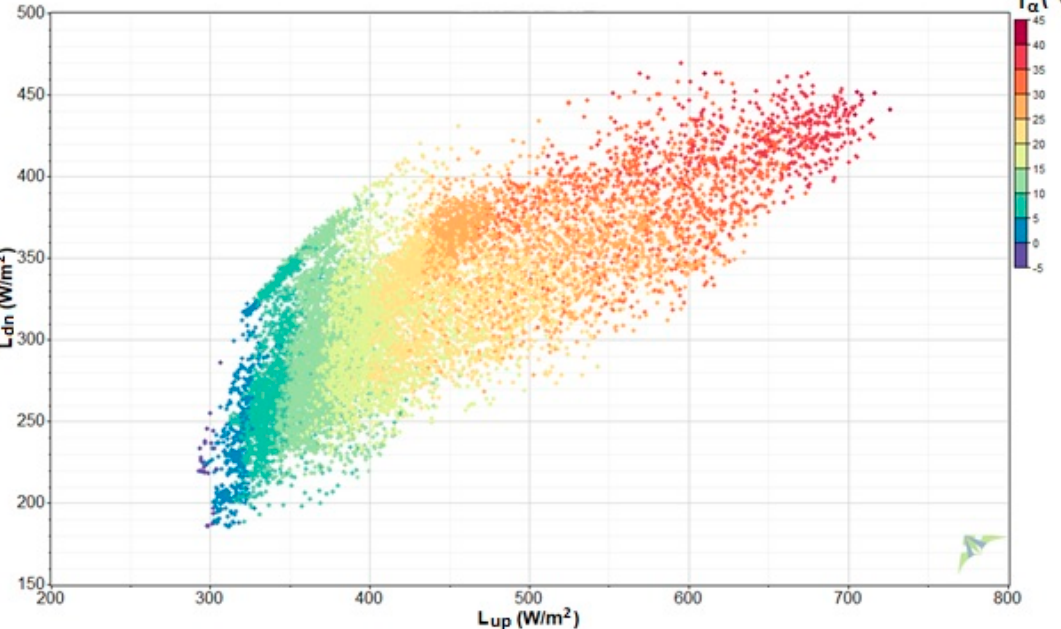
Figure 3. The effect of air temperature at the screen level on both the downward and upward longwave irradiances.